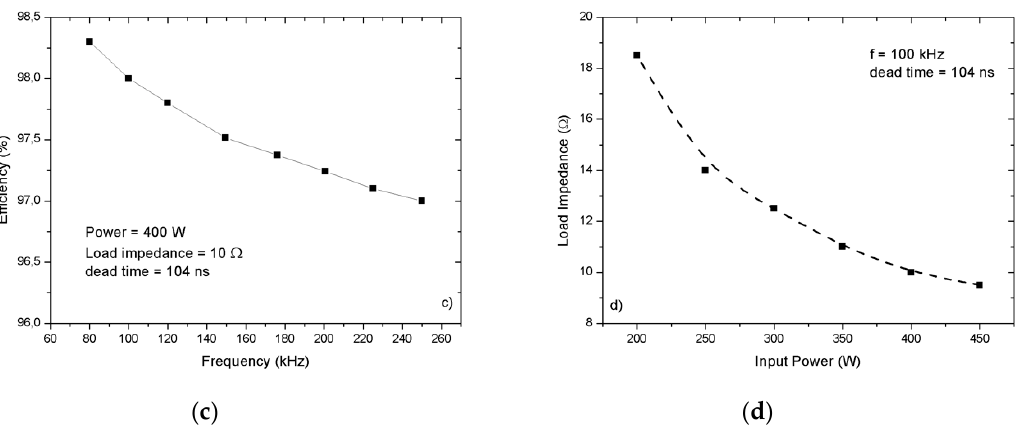
Figure 9. Efficiency ( η ) for different values of input power ( a ), of dead-time ( b ) and of switching frequency ( c ). In figure ( d ) is reported the optimal load impedance as a function of the input power.